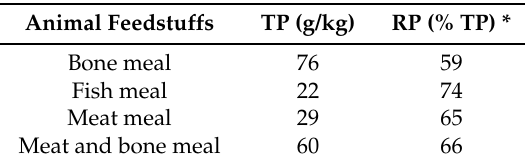
Table 4. Total P (TP) (g/kg), retainable P (RP) (% of TP) of animal-derived feedstuffs in three-week-old broilers